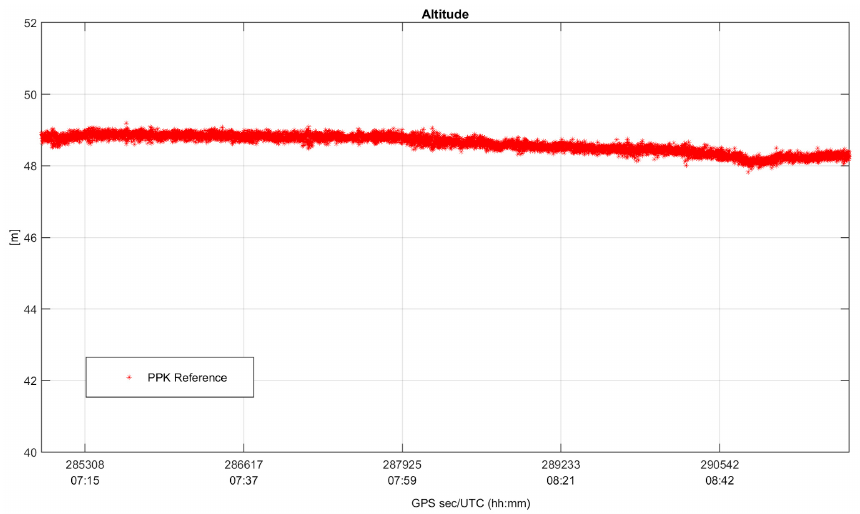
Figure 9. The altitude values obtained applying PPK mode and used for the error analysis.